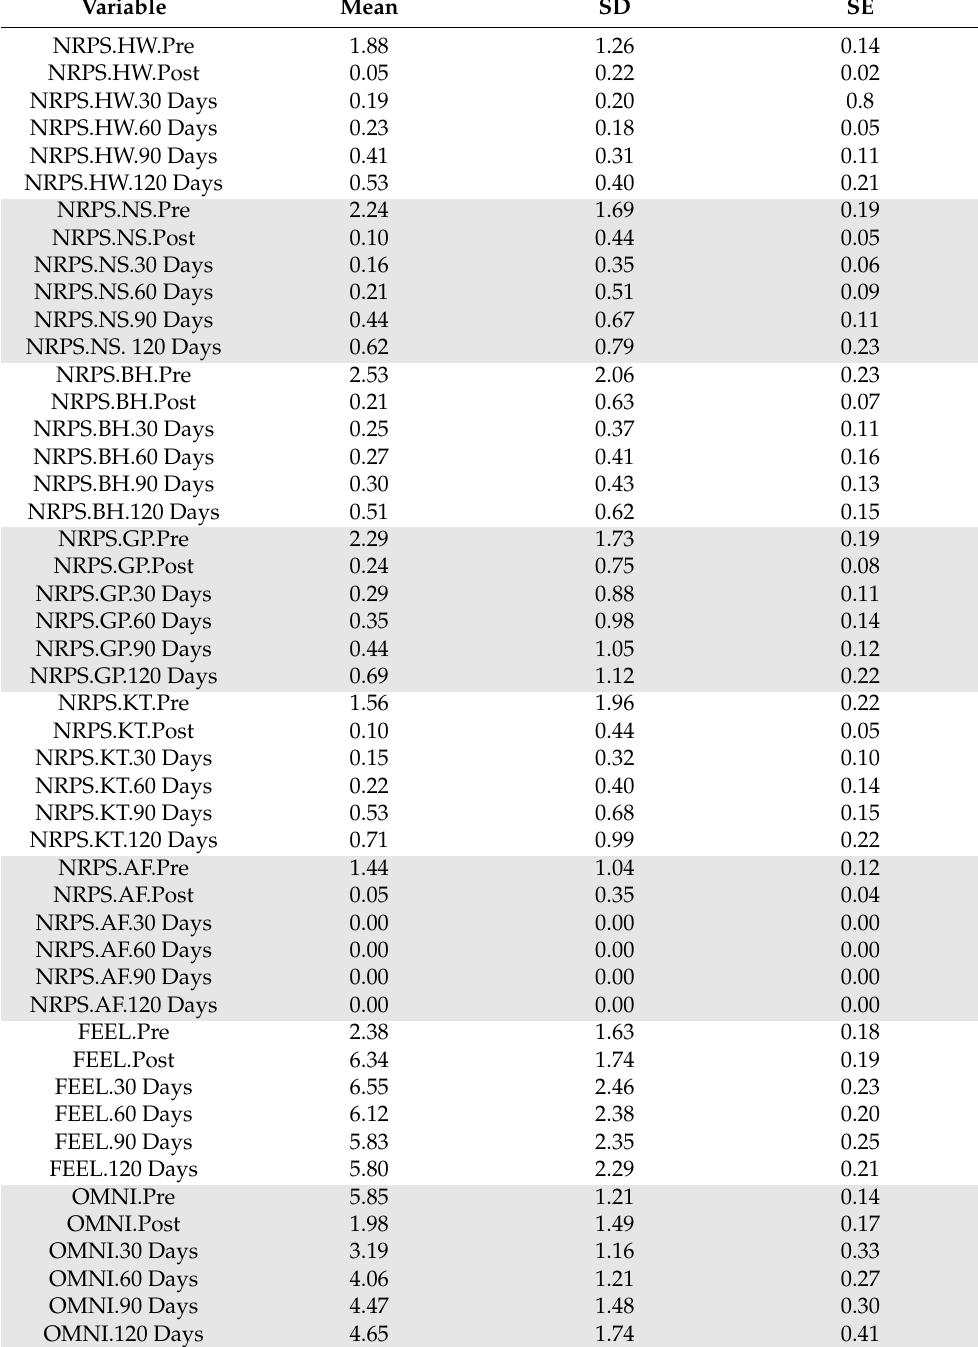
Table 3. Descriptive analysis of all